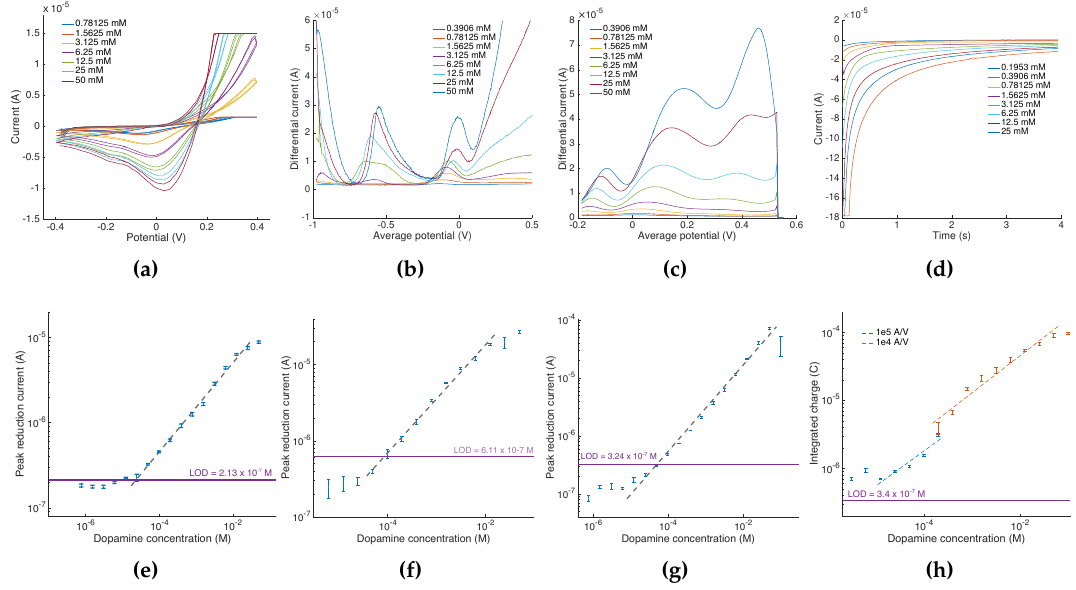
Figure 7. Mobile phone acquisition data. ( a ) Cyclic voltammograms: the calibration point is obtained from retrieving local maxima around E = 0V; ( b ) SWCV acquisitions: the calibration point is obtained from retrieving local maxima around E = 0V; ( c ) DPV acquisitions: the calibration point is obtained from retrieving local maxima for 0 < E < 0.2V; ( d ) amperometry: the calibration point is obtained by integrating the current value for the entire duration of the acquisition. Saturated acquisitions are only discarded when saturation occurs within the potential range of interest. In the specific case of amperometry, acquisitions are discarded if the current is saturated at t = 0 (e.g., acquisition at 25mol · L − 1 in quadrant d was discarded and repeated with a lower input current sensitivity). ( e – h ) Calibration curves for electrochemical scheme respectively illustrated in